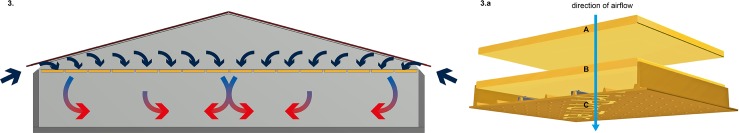
Cross section of barn 2 demonstrating the distribution of fresh air and composition of the perforated polyurethane cassettes used for supply air filtration in barn 2.(3.) Each filter unit consisted of a polyurethane cassette and two glass wool filters. These units (indicated in yellow) were installed into the barn attic without gaps. Fresh air entered the attic via slots underneath the roof (dark blue arrows). Air flow (indicated as multicolored arrows) was regulated by negative pressure. (3.a) Each air filter unit in the attic of barn 2 was composed of two glass wool filter mats (A, B) embedded in a perforated polyurethane cassette (C). Each mat sized 1,200 mm x 1,200 mm and had a thickness of 40 mm. The direction of airflow through each cassette is indicated by a blue arrow.